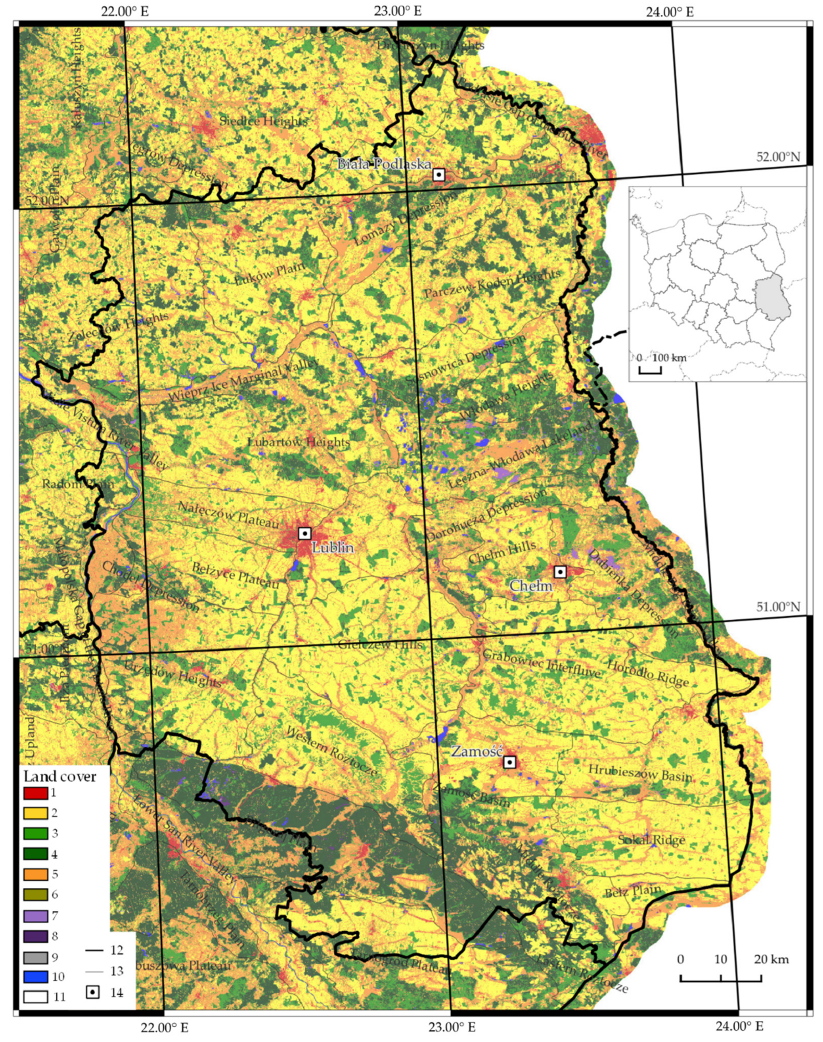
Figure 1. Land cover in Lubelskie Province against the physical-geographical division. (1) anthropogenic areas; (2) agricultural areas; (3) deciduous forests; (4) coniferous forests; (5) grassland; (6) heaths and shrubs; (7) wetlands; (8) peat-bogs; (9) natural areas devoid of vegetation; (10) water areas; (11) no data; (12) provinces; (13) mesoregions; (14) major towns and cities (source: [80,84]). In 2020, Lublin had a population of 338,856. Young adults (aged 19–24) accounted for about 5% of the inhabitants. In terms of the number of students, Lublin is among the top academic centres in Poland and the largest in the eastern part of the country. There are nine universities (five public and four non-public) with about 60,000 students, including